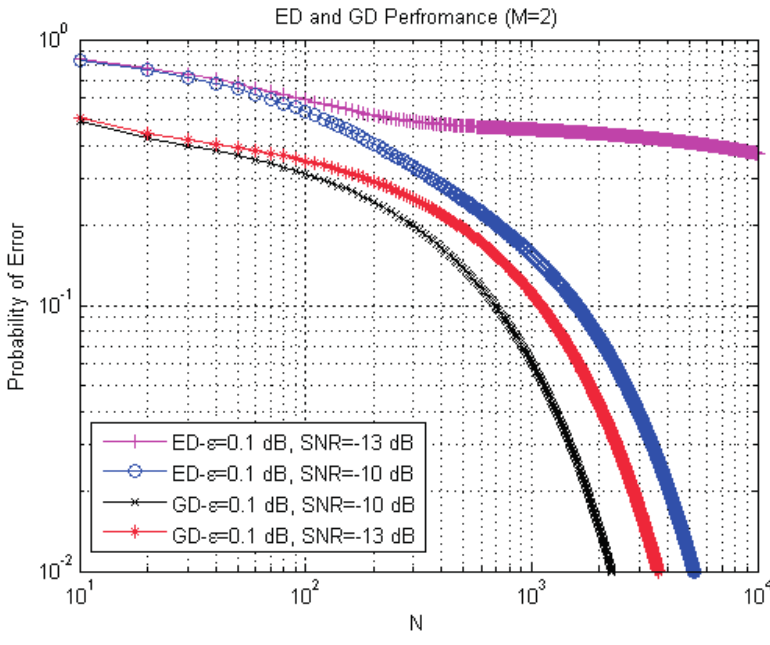
Figure 8. Spectrum sensing performance for the ED and GD in terms of the probability of P as a function of the sample error er